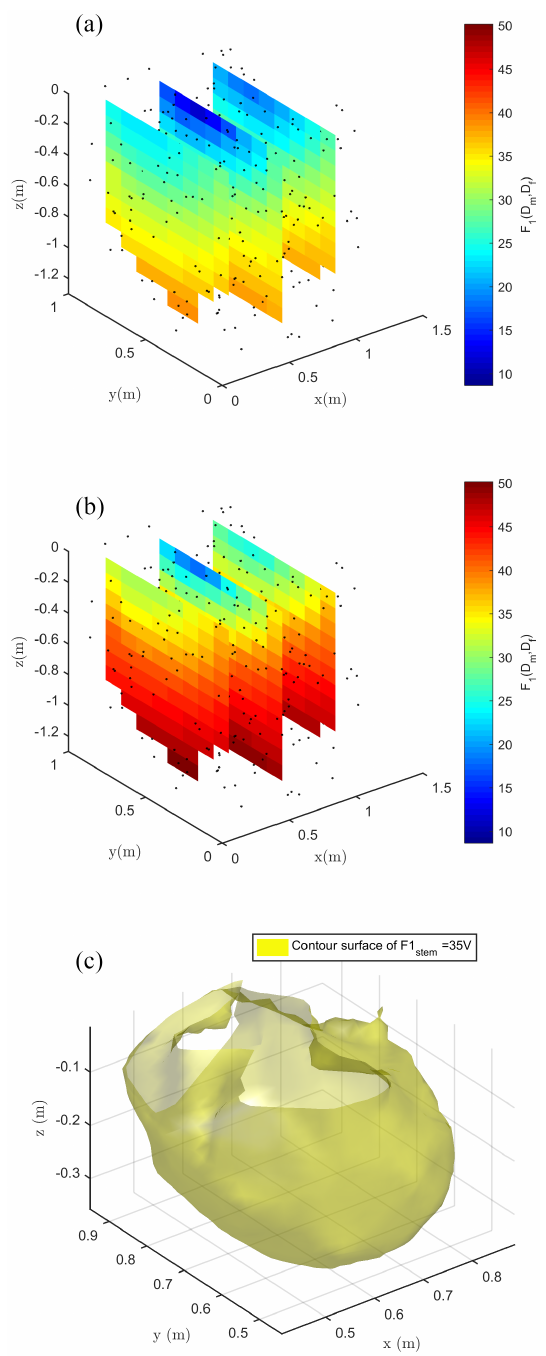
Figure 8. Spatial distribution of the F1 misfit function (e.g., Eq. 1) computed against field data and using the ERT-derived electrical re- sistivity distribution. (a) shows the case with stem injection, (b) the case with soil injection and (c) the contour surface of F1 = 17V in the stem injection case for which only locations that would con- tribute in a substantial manner to reducing the F1 misfit are